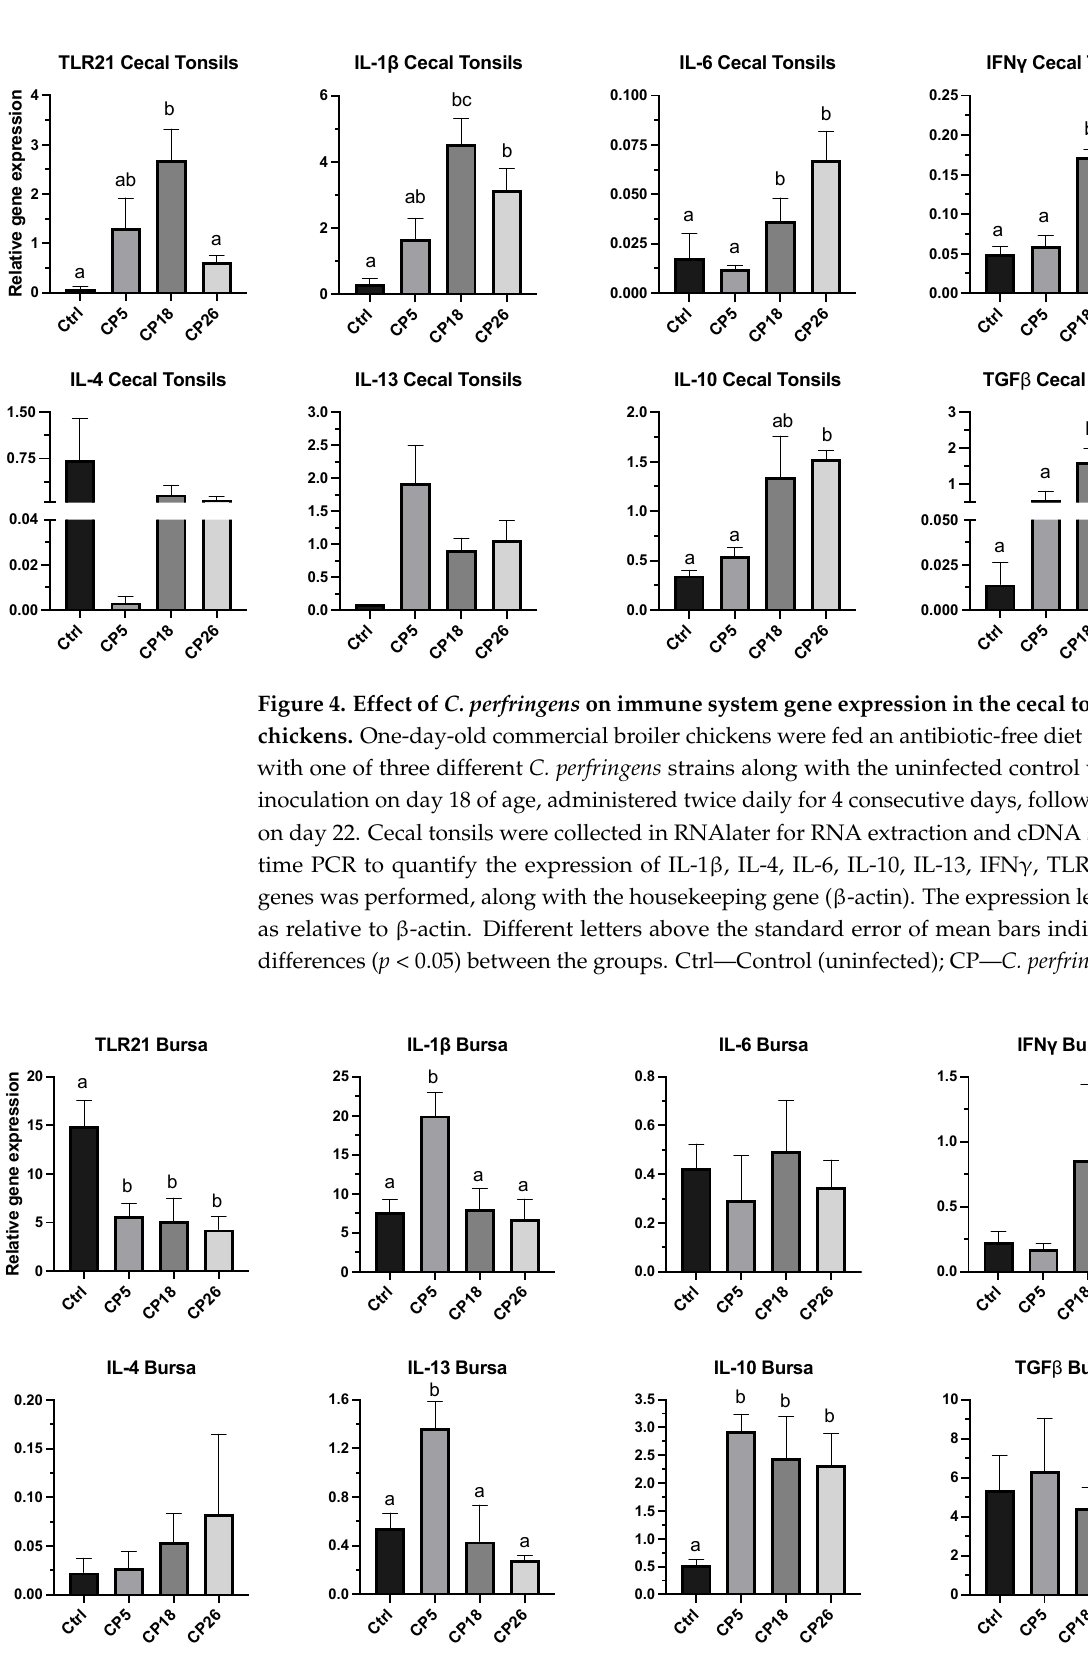
Figure 5. Effect of C. perfringens on immune gene expression in the bursa of Fabricius of broiler chickens. One-day-old commercial broiler chickens were fed an antibiotic-free diet and challenged with one of three different C. perfringens strains along with the uninfected control via intracloacal inoculation on day 18 of age, administered twice daily for 4 consecutive days, followed by necropsy on day 22. Bursa were collected in RNAlater for RNA extraction and cDNA synthesis. Real-time PCR to quantify the expression of IL-1 β , IL-4, IL-6, IL-10, IL-13, IFN γ , TLR-21, and TGF β genes was performed along with the housekeeping gene ( β -actin). The expression levels are shown as relative to β -actin. Different letters above the standard error of mean bars indicate significant difference ( p < 0.05) between the groups. Ctrl—Control (uninfected); CP— C. perfringens strain. 3.3.3. Harderian Gland As shown in Figure 6, the expression of IL-4 and IL-13 in CP5-infected birds was increased ( p < 0.05) compared to the control, CP18, and CP26 groups. The expression of IFN γ in all infected groups was decreased ( p < 0.05) compared to the control. No significant changes were observed in the expression of TLR-21, IL-1 β , IL-6, IL-10, or TGF β between the infected and control groups.